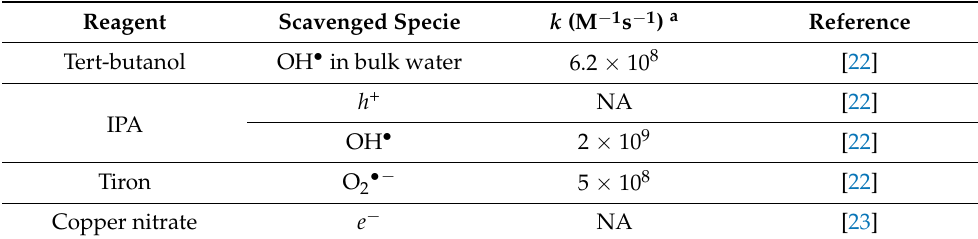
Table 1. Chemical reagents used as OH • , h + , O 2 •− and e − scavengers.